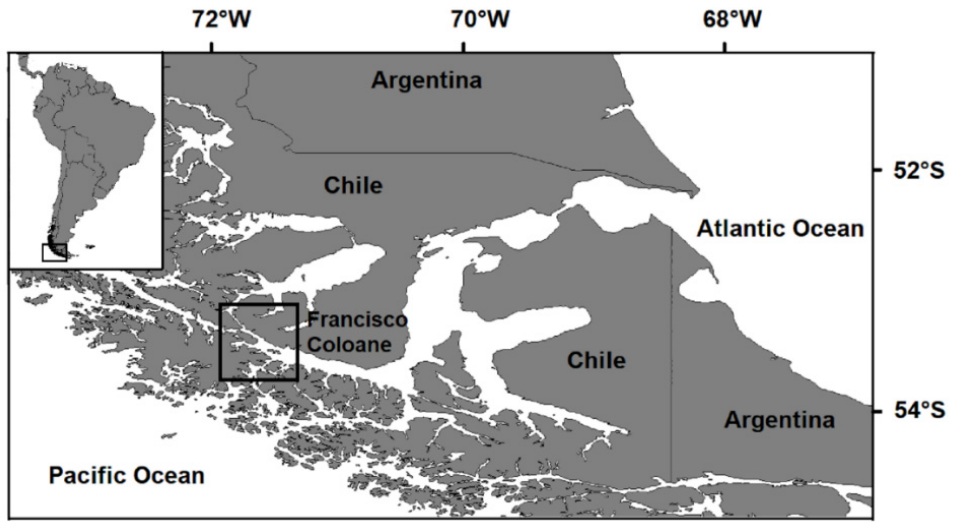
Figure 1. Study area in Chile: Francisco Coloane Marine and Coastal Protected Area in the Magellan Strait, Chile (square). Table 1. Basic input parameters and biomasses of the functional groups of the model in the Fran- cisco Coloane Marine Area, Magellan Strait. B: biomass (t km 2 ), P/B: production/biomass (year − 1 ), Q/B: consumption/biomass (year − 1 ), EE: ecotrophic efficiency, Y: fishing landing (t km 2 year − 1 ). Val- ues estimated by the model are in bold.